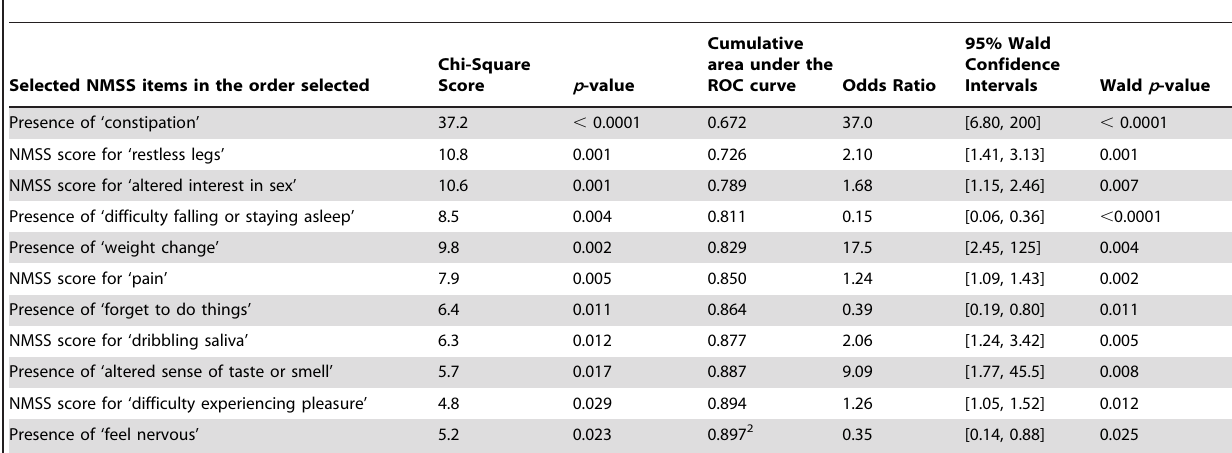
Table 6. Selection of NMSS items by stepwise logistic regression 1 to discriminate between PD patients (n =200) and HFS patients